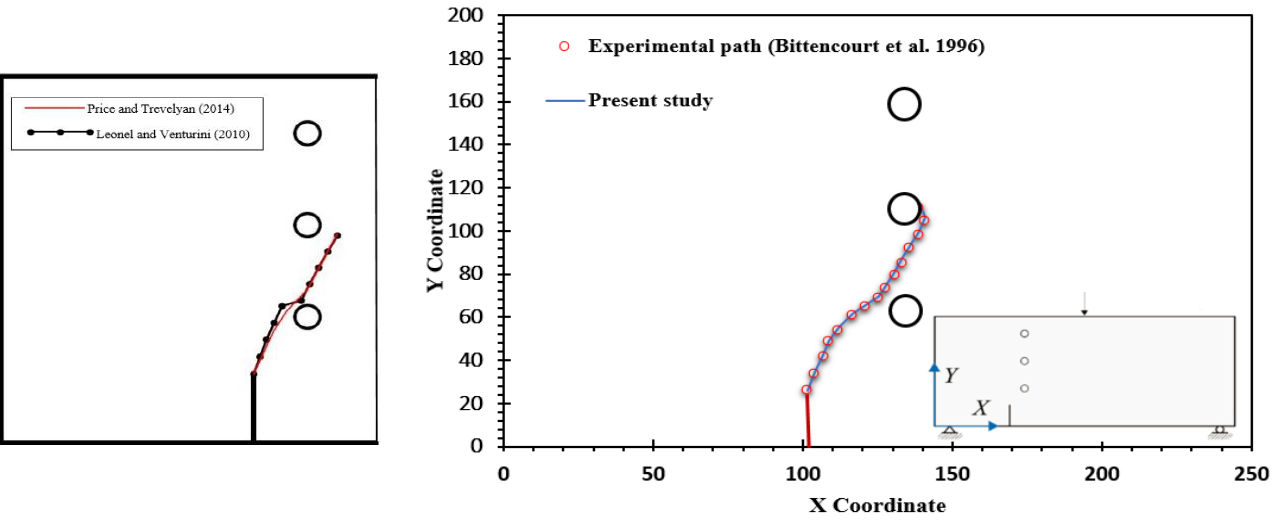
Figure 4. Crack growth path using the Dual Boundary Element Method (DBEM) [48] and the Boundary element method (BEM) [49] ( left ), Ansys and experimental crack trajectory for the crack tip coordinate of specimen 1 ( right ).